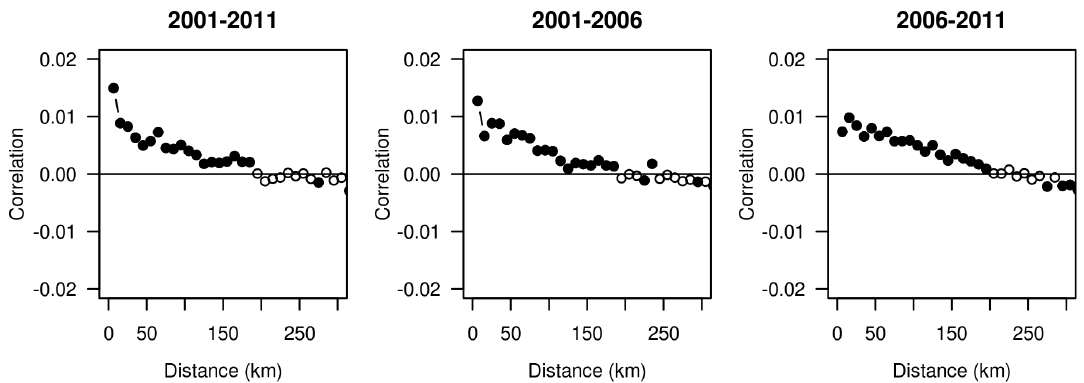
Figure A3. Correlograms of Moran’s I spatial autocorrelation of residuals from BRT models of the probability of development for the time intervals 2001–2011, 2001–2006 and 2006–2011. Points with significance at the α =0.05 level are